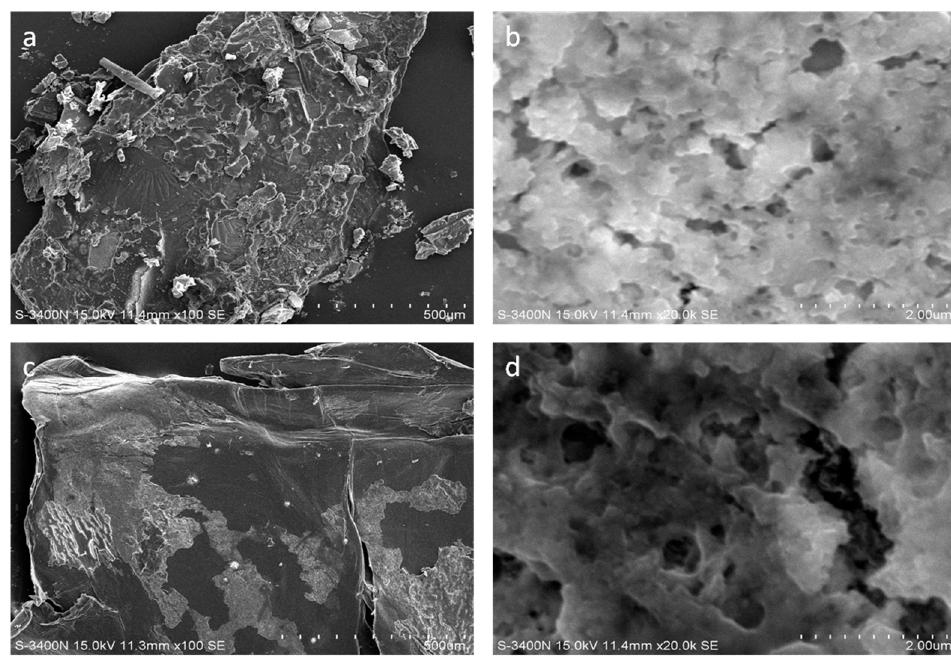
Figure 2. SEM morphology of the shrimp shell ( a , b ) and MS ( c , d